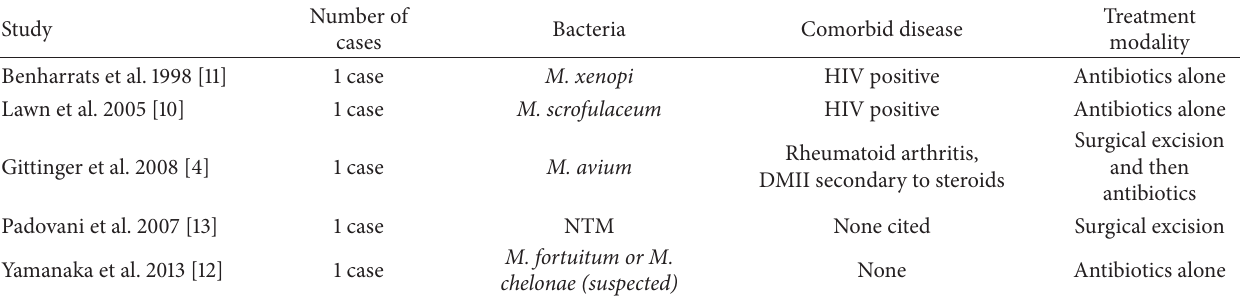
Table 1: Summary of case reports of NTM parotid infection in adults